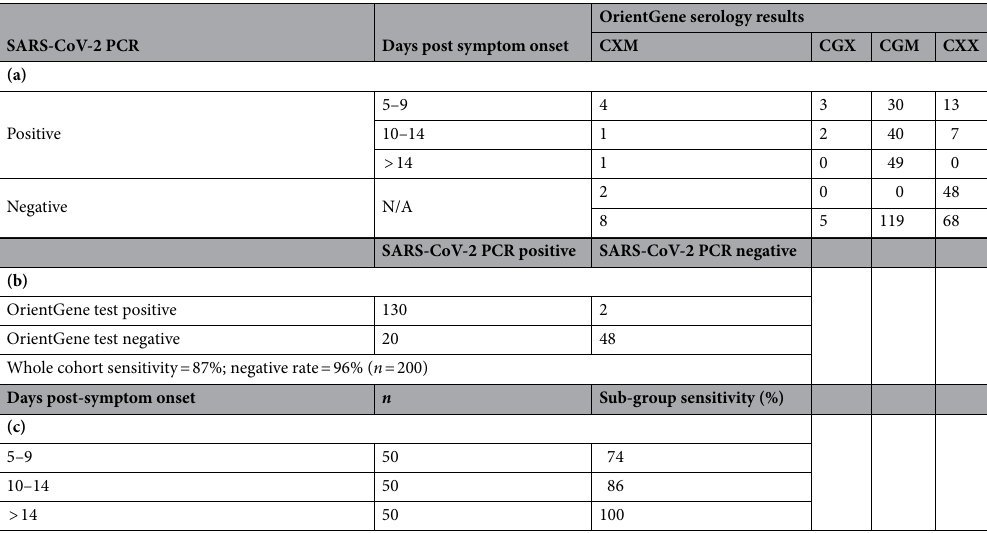
Table 1. OrientGene point-of-care SARS-CoV-2 serology testing ( n = 200) among inpatients, March–April 2020, London. (a) Control, IgM, and IgG line detection across different symptom durations, where C control line only, G IgM line observed, M IgM line observed. (b) Sensitivity and negative rate across all 200 assays. (c) Sensitivity and negative rate across different symptom